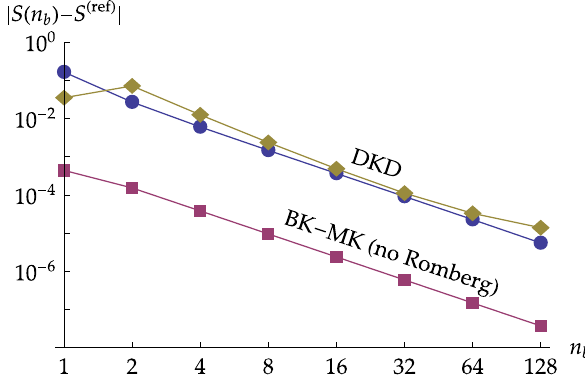
FIG. 14. Single-turn spin errors as a function of the number of slices for several different integrators: drift-kick (blue circles, tan diamonds), and BK/MK (purple squares). The blue circles represent DKSKD: traverse each slice using half-drift, half-kick, spin rotation, half-kick, half-drift. The purple squares represent DKDSDKD: traverse each slice using half-DKD, spin rotation, half-DKD. The reference solution used BK/MK with n together with three Romberg iterations.